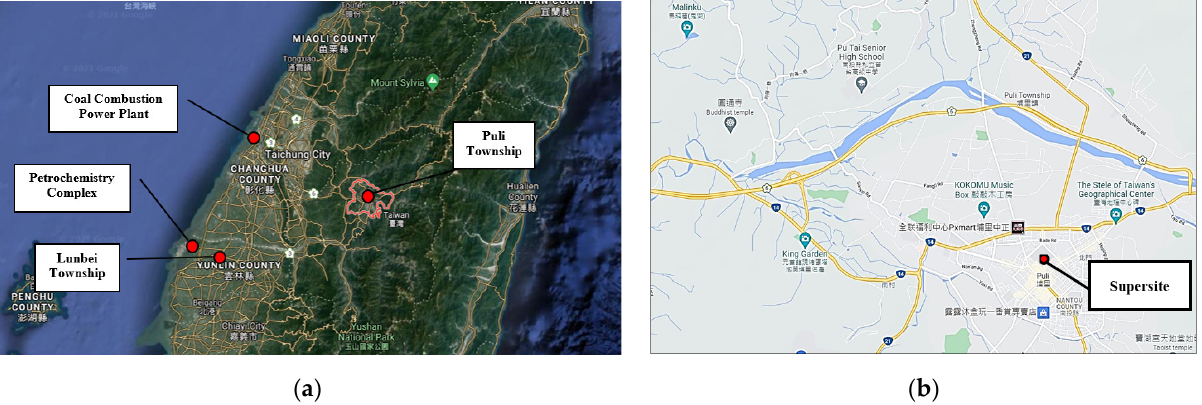
Figure 3. The investigated site. ( a ) Location of Puli township and two potential external pollution sources. ( b ) Geography of Puli township and the Taiwan EPA supersite (located at the Puli middle school).